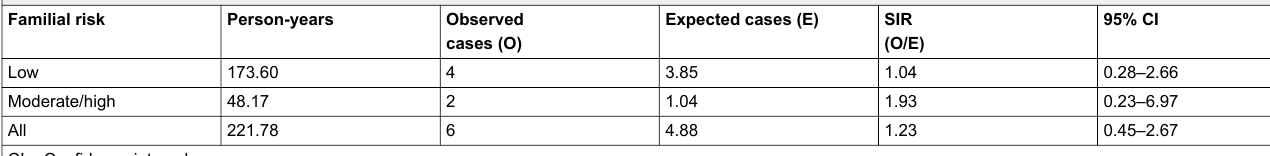
Table 2 : Standardised incidence rates (SIRs) of secondary cancer among men with breast cancer according to familial risk of breast cancer. Familial